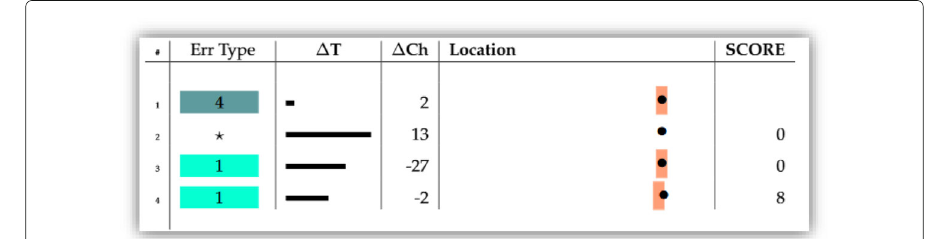
Fig. 2 An example of a four-event session (Jadud